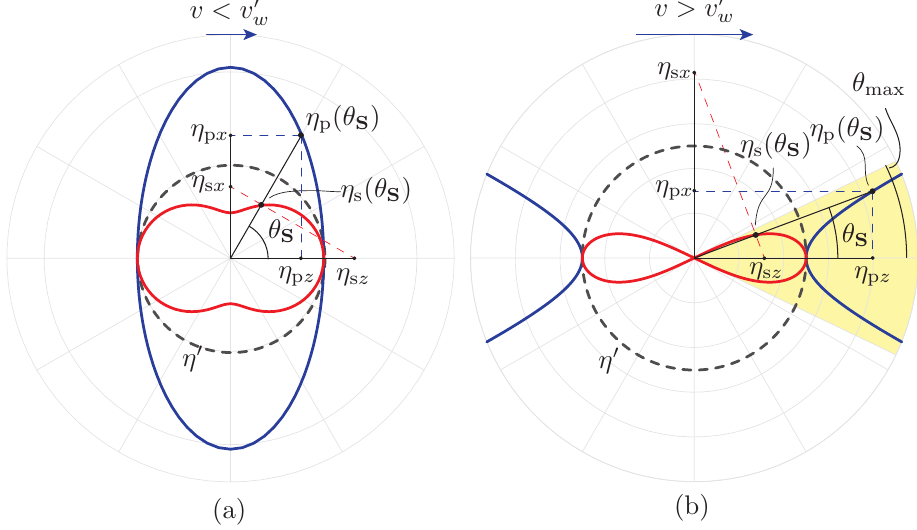
Figure 4. Impedance diagram (Equations (19) and (20)) for a moving dielectric (fluid) medium with n (cid:48) = 2 ( v (cid:48) w = c /2) and η (cid:48) = η 0 /2. The dashed circles correspond to the isotropic curves at v = 0. ( a ) Subluminal regime, with velocity v = 0.45 c < v (cid:48) w ; ( b ) Interluminal regime, with v = 0.8 c > v (cid:48) w . The highlighted region corresponds to the region of physical solutions, with θ max = arctan Figure 4b corresponds to the interluminal regime. The p-polarization impedance